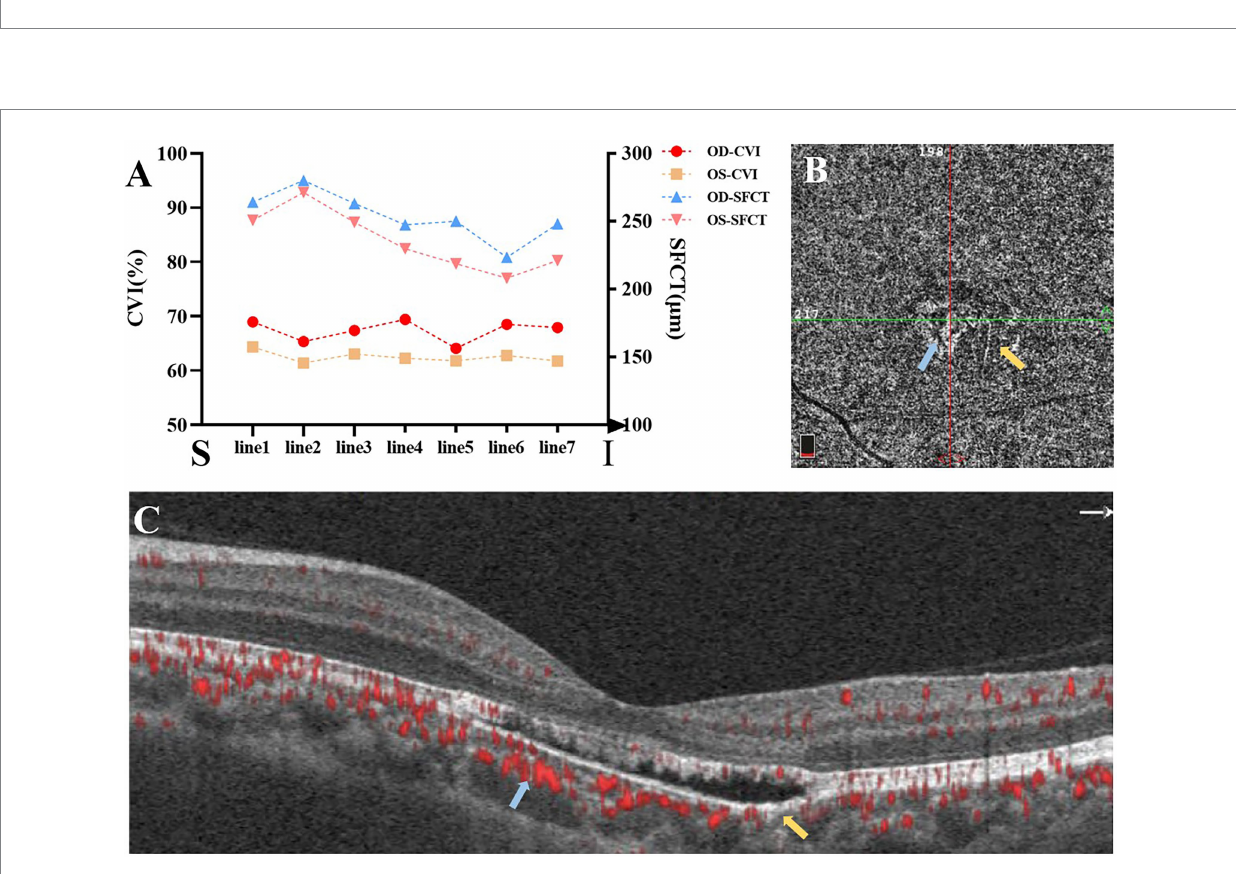
FIGURE 2 (A) The choroidal vascularity index (CVI) and sub-foveal choroidal thickness (SFCT) of seven horizontal lines from superior to inferior passing through the fovea (S: superior; I: inferior). (B,C) OCTA showed reduced density of the choriocapillaris in the temporal lesion (yellow arrows) and increased density in the nasal lesion (blue